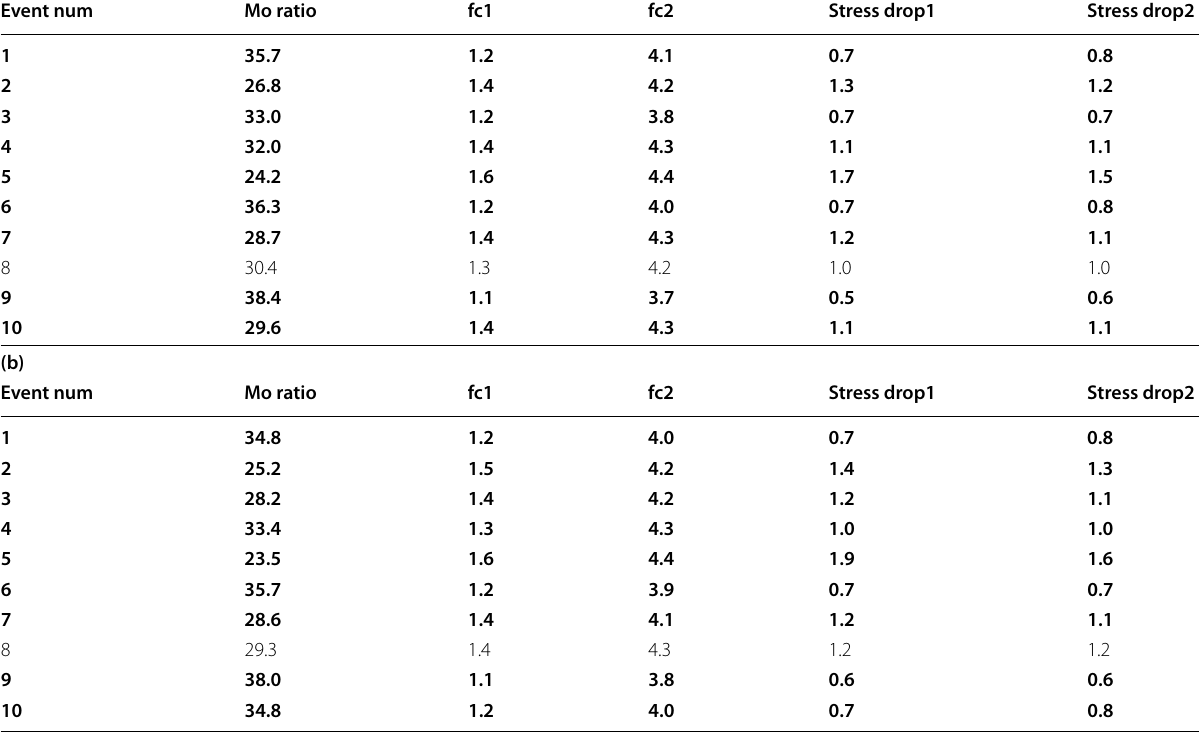
Table 2 (a) Estimated parameters for the first ten events in the synthetic data assuming a F-distribution. Rows list (from left to right) event number, estimated moment ratio, estimated corner frequency of the large earthquake (Hz), the estimated corner frequency of the small earthquake (Hz), stress drop estimated for a large earthquake (MPa), and the stress drop estimated for a small earthquake event (MPa). Thin characters indicates the selected event presented in Fig. 2. (b) Estimated parameters for synthetic data assuming a normal